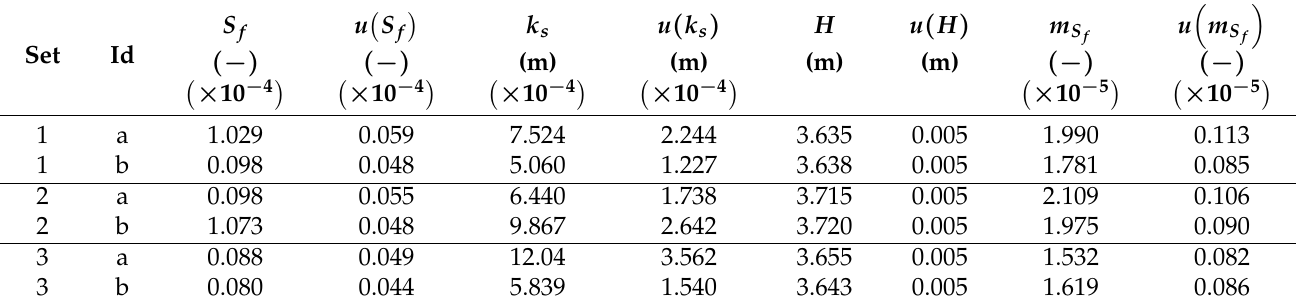
Table 5. Optimal state variables and their associated uncertainties in section GG7 from SE. Coverage coefficient— k =